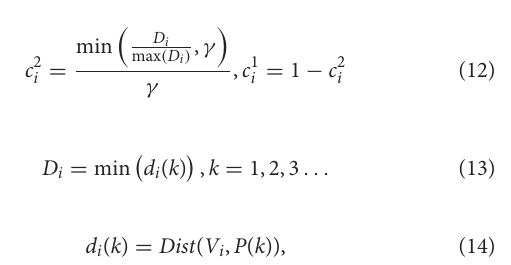
same intensities. Thus, we can obtain the intensity difference value between the two overlapping image